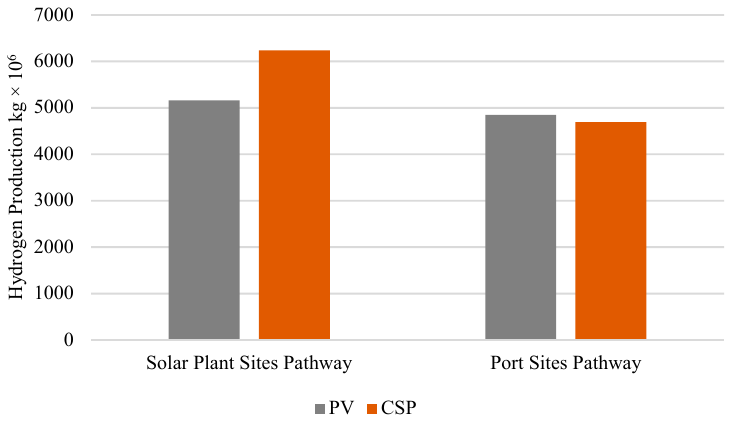
Figure 9. Hydrogen produced for all location scenarios in the 25 km scenario.